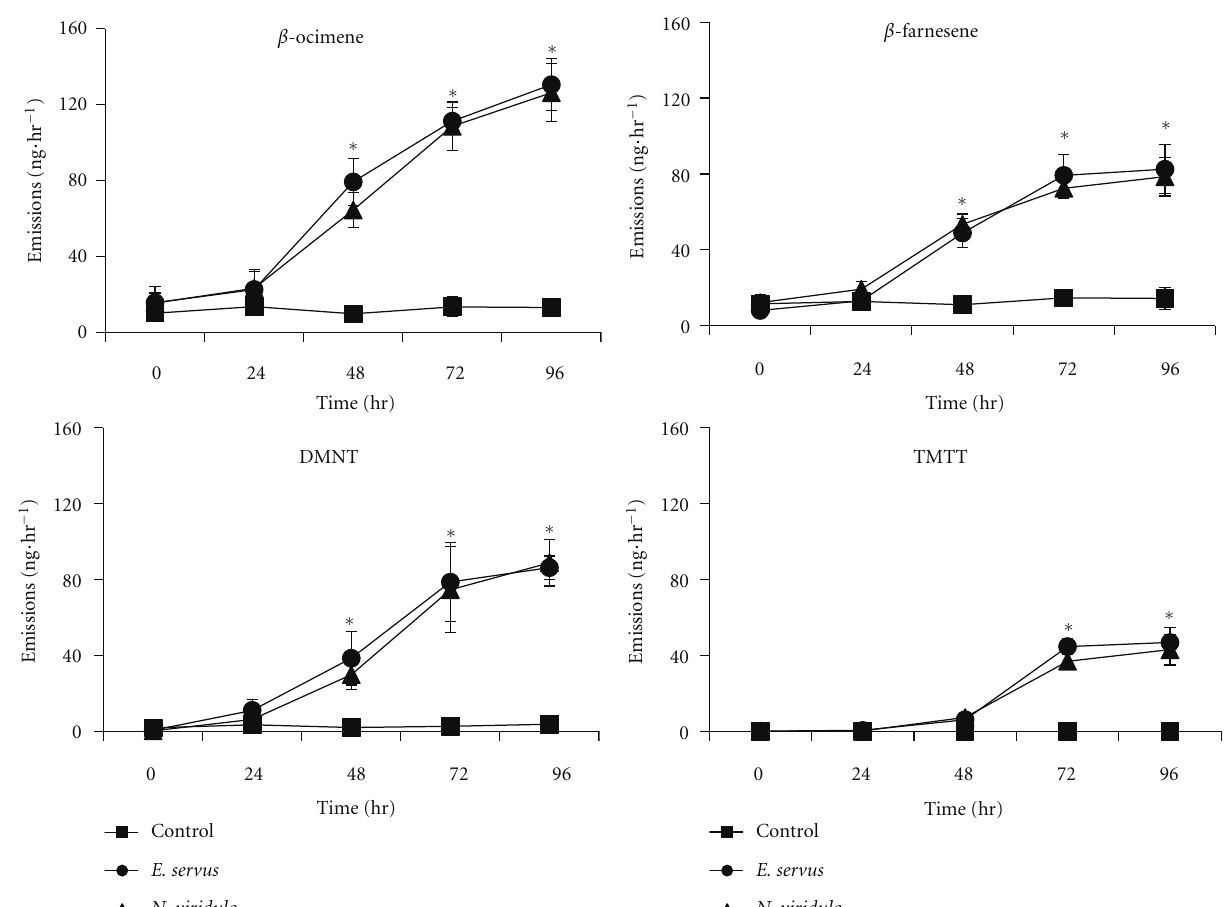
Figure 2: Temporal dynamics of induced VOC emissions from cotton bolls exposed to Euschistus servus and Nezara viridula and unexposed (control) bolls under field conditions. Data points represent mean VOC emissions ( ± 1 SE; n = 5). Asterisks indicate significant di ff erence ( P < 0 . 05) between control and infested bolls.